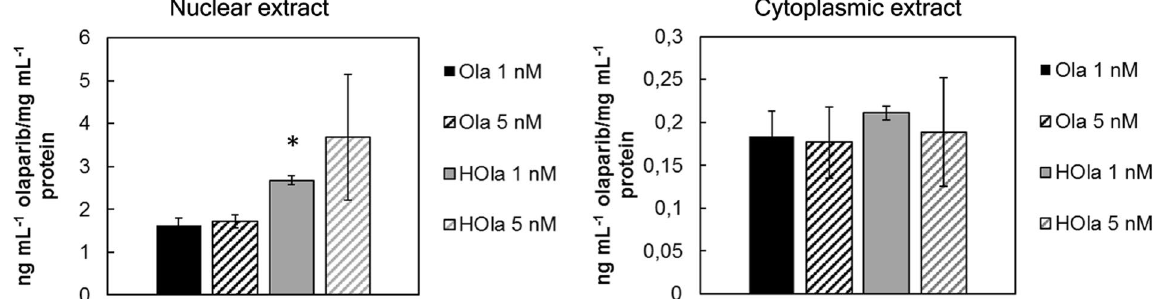
Figure 8. HOla promotes the drug transport into the nuclear compartment. HCC1937 were treated with increasing concentration of Ola or HOla (1 and 5 nM) for 72 h. At the end of incubation, cells were collected by tripsinization and subjected to cell fractionation to obtain crude nuclei and cytoplasmic extract. The protein content of each fraction was assessed by Bradford assay and used for normalization. Samples were processed for HPLC-MS quantification of Ola. Reported values are the mean of 2 samples ± s.e. Statistical significance HOla vs . Ola * P < 0.05 (Student’s t